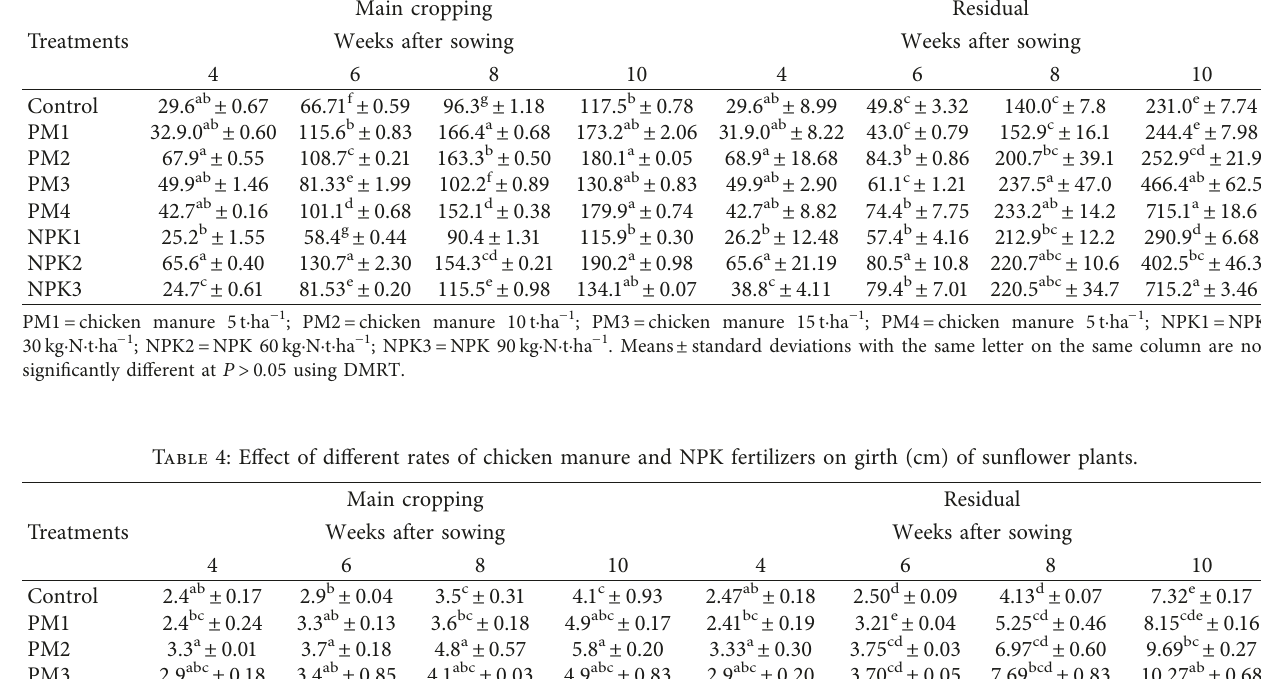
Table 3: Effect of different rates of chicken manure and NPK fertilizers on the leaf area (cm 2 ) of sunflowers. Main cropping Residual Treatments Weeks after sowing Weeks after